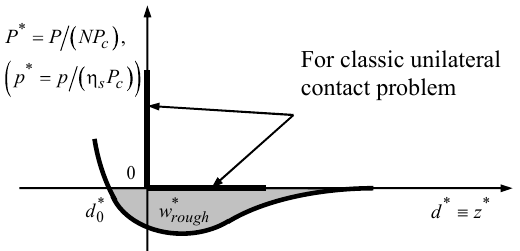
Figure 1. The force-distance scheme for the classic unilateral contact and adhesive contact with a rough surface. The area of the grey-coloured zone is equal to the specific work of adhesion w rough